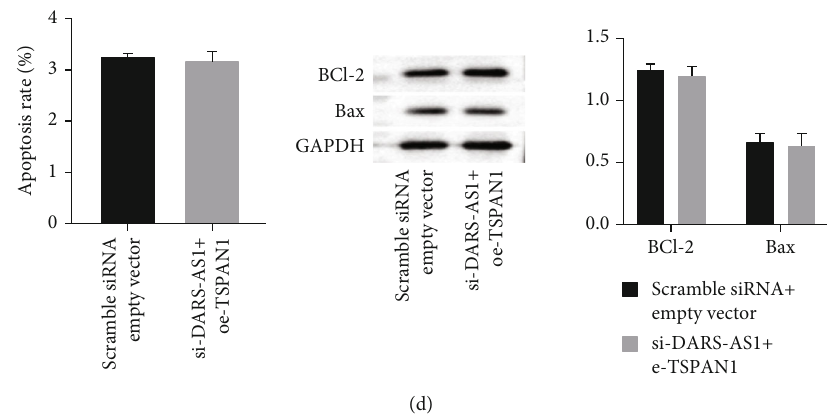
Figure 5: The functions of DARS-AS1/miR-194-5p/TSPAN1 in OC. (a) qRT-PCR detection and western blotting of TSPAN1 mRNA and protein expressions in A2780 cells following transfection with si-DARS-AS1 and/or oe-TSPAN1. (b) CCK-8 assay detection of A2780 cell viability following transfection with si-DARS-AS1 and/or oe-TSPAN1. (c) Representative migratory or invasive A2780 cells per fi eld and numbers of migratory or invasive cells following transfection with si-DARS-AS1 and/or oe-TSPAN1. (d) Apoptosis rates of A2780 cells, western blots, and gray values of apoptosis-related proteins in A2780 cells following transfection with si-DARS-AS1 and/or